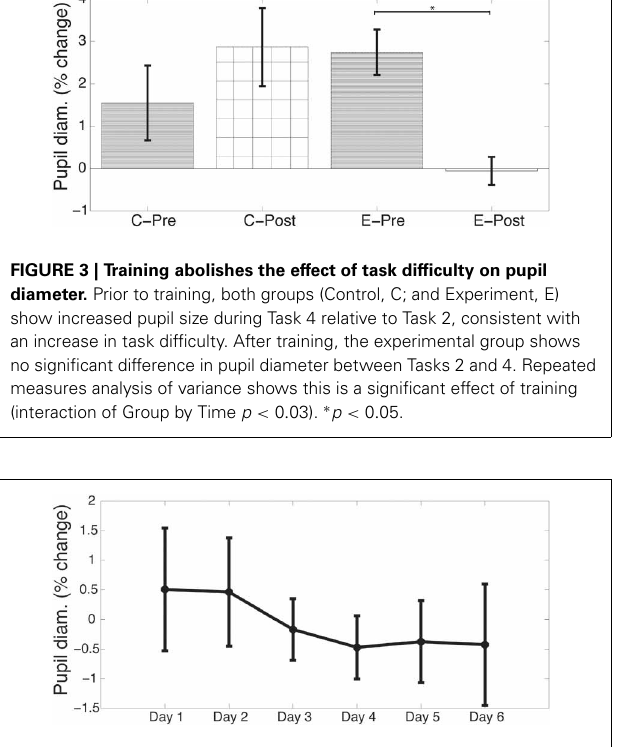
FIGURE 4 | Effect of task difficulty decreases throughout training. Data from the first session of each training day are included here. No significant differences were observed ( p > 0 . 05). However, the difference between tasks grows closer to 0 over time, consistent with the finding that pupil diameter during tasks of varying difficulties become more similar through